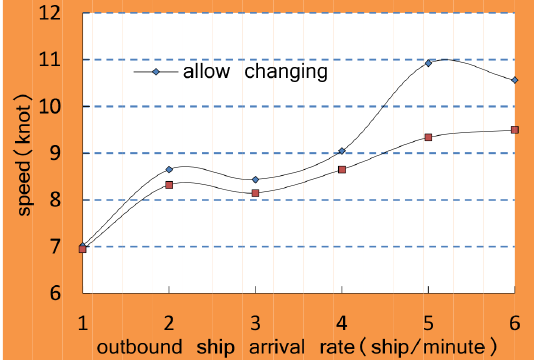
Figure 25. Average speed of waterway system and ship arrival rate as a